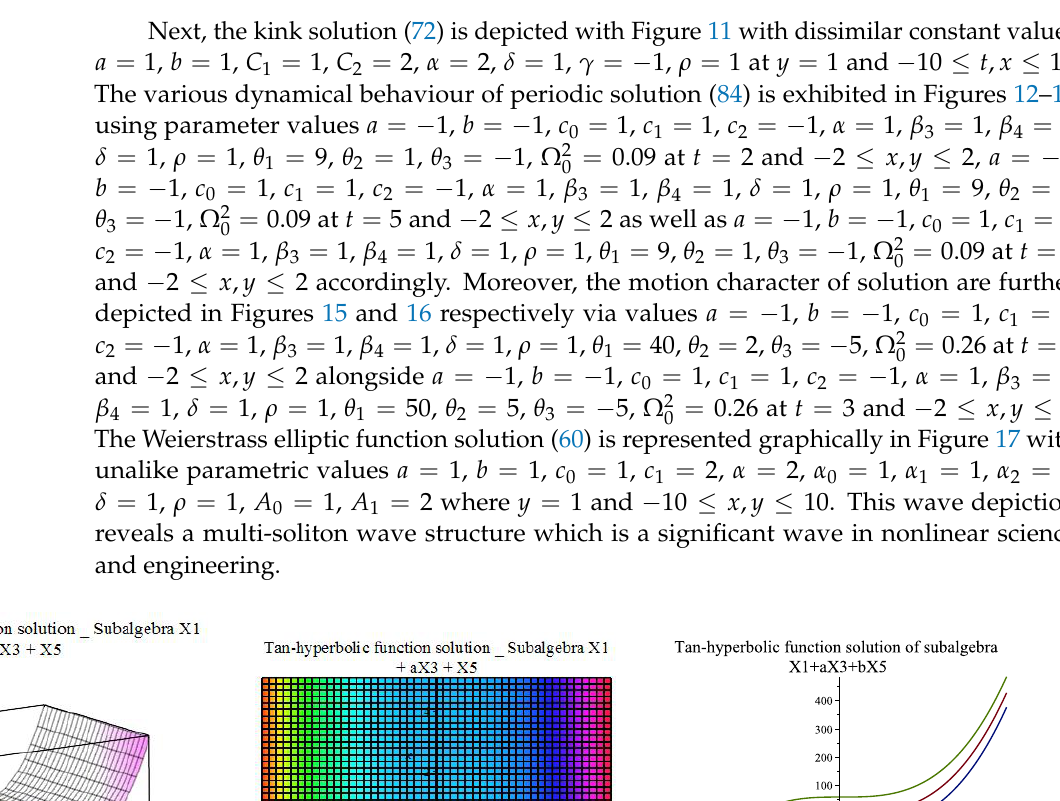
Figure 10. Wave profile depiction of soliton interaction at varying amplitude and propagating at a constant velocity and also moving in different directions when x = 0.